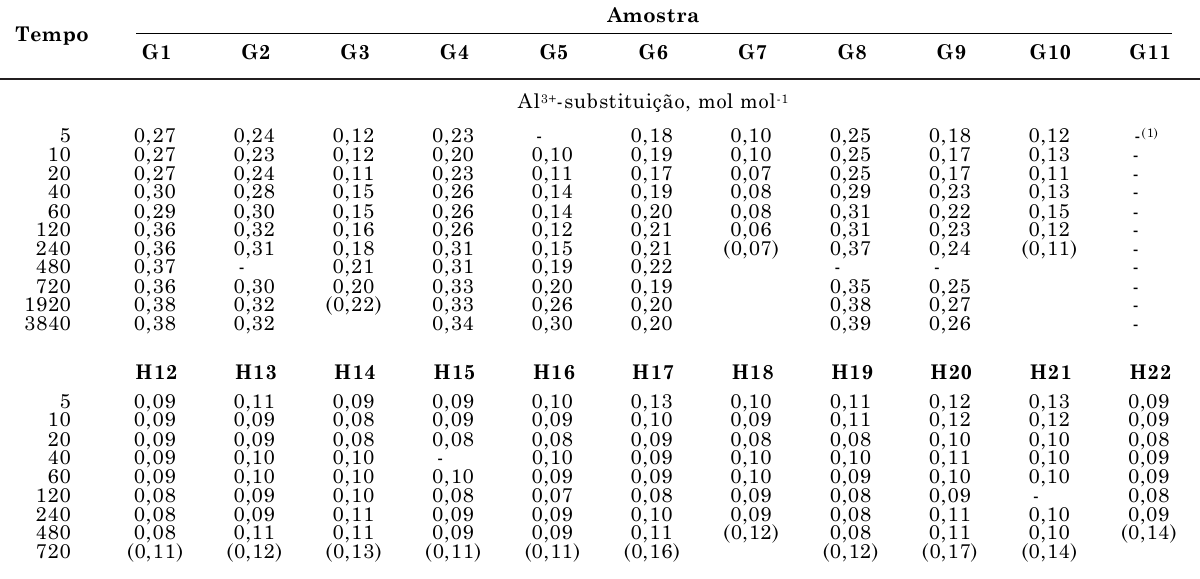
(1) - Alíquota perdida. ( ) Dissolução